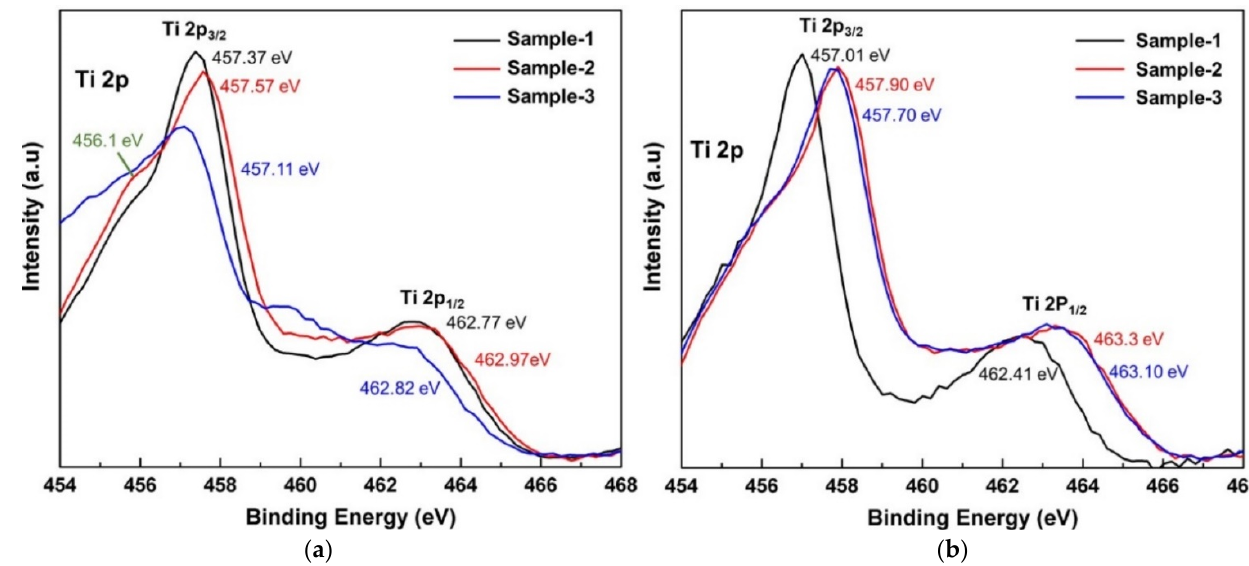
Figure 8. XPS curve of the internal area of the Ti-TiO 2 bilayer thin film at different oxidation temperatures: binding energy curves of Ti 2p, employing a Shirley-type background oxidized at ( a ) 450 °C and ( b ) 550 ° C.